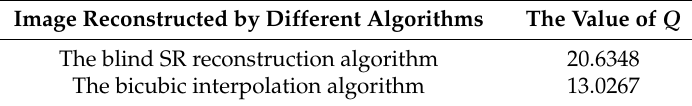
Table 1. The nominal values of metric Q of two reconstructed images.